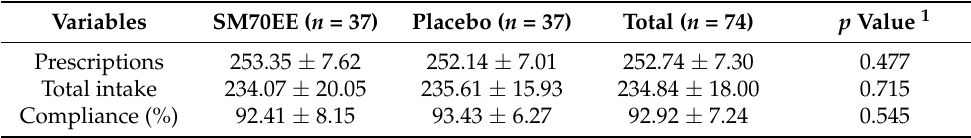
Table 2. Evaluation of compliance among the